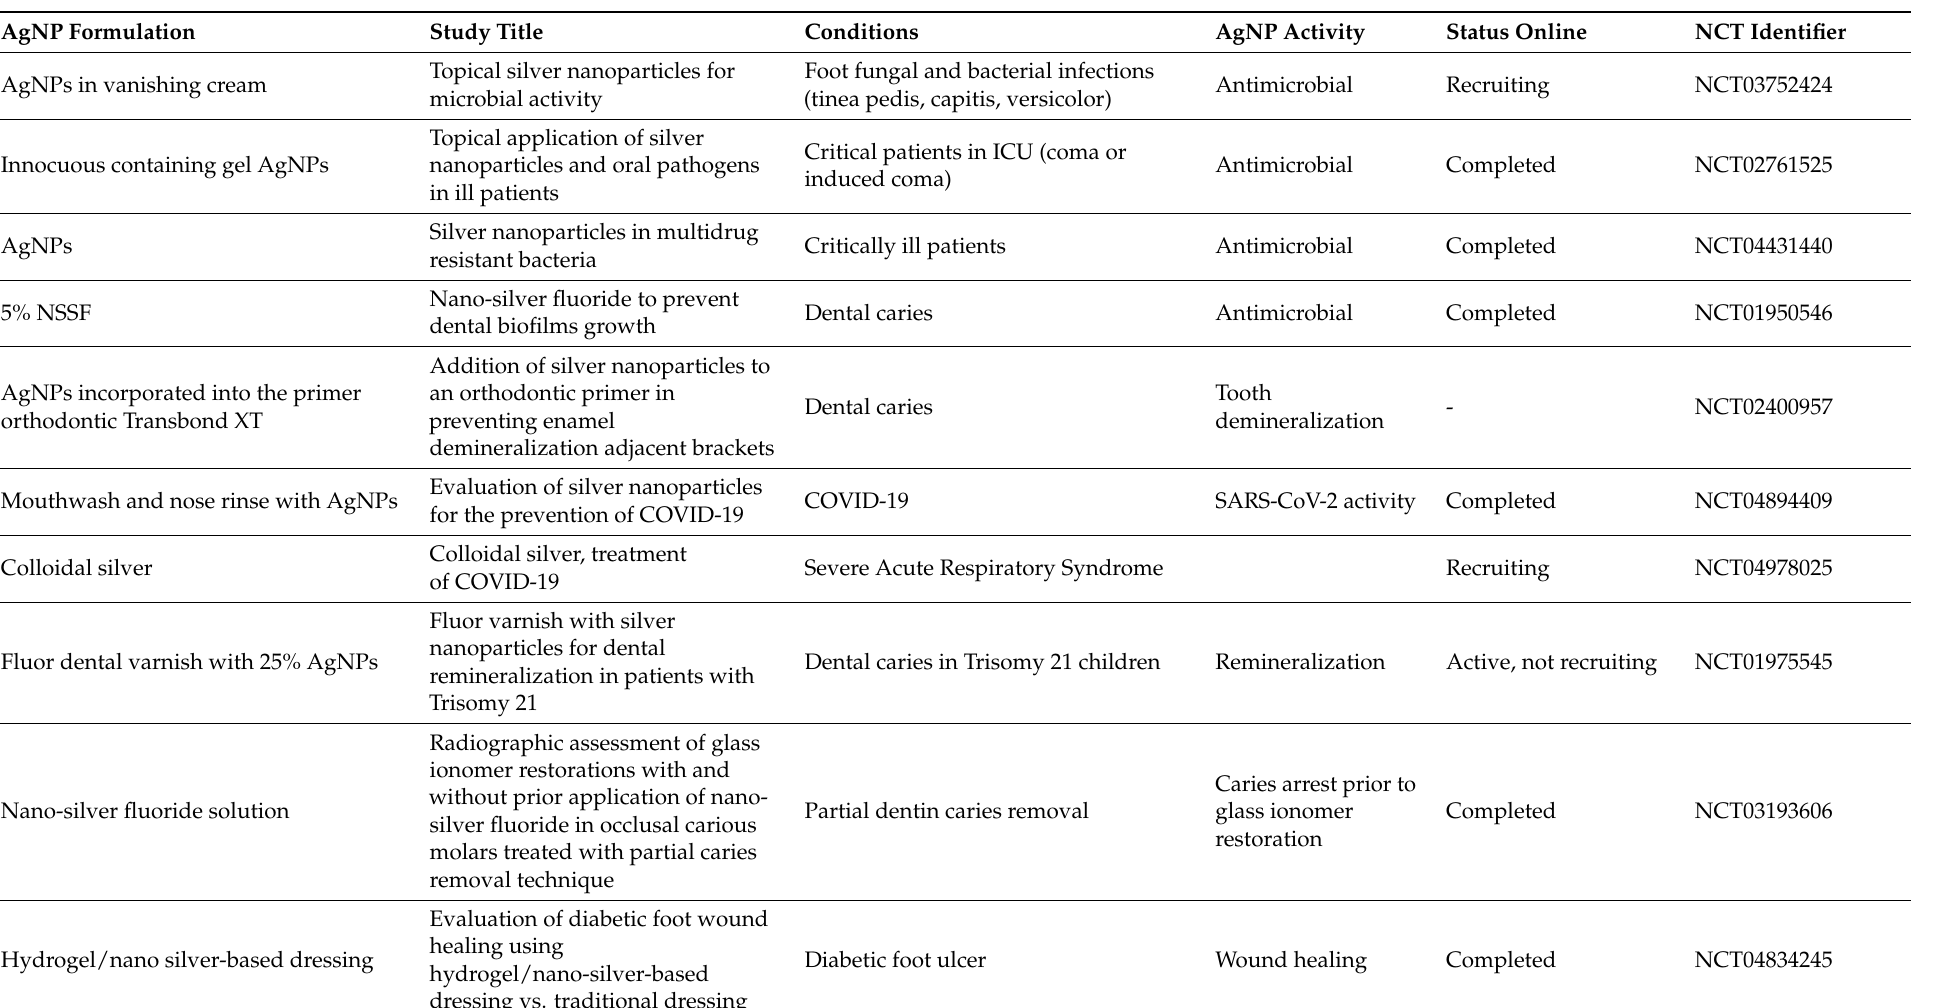
Table 2. AgNP-based formulations registered for clinical